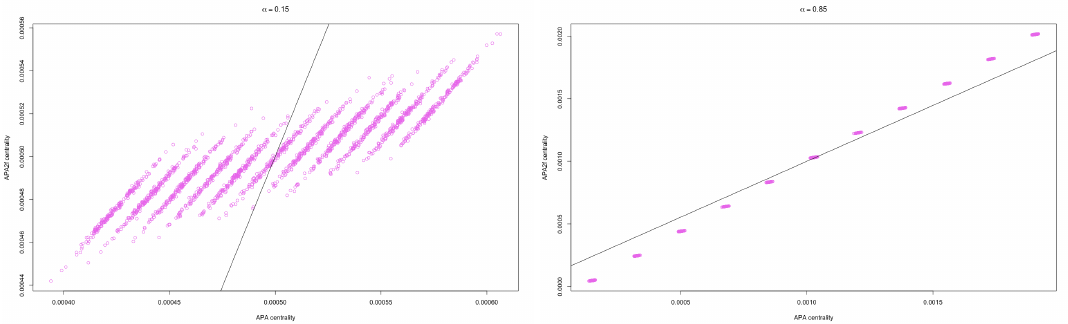
Figure 9. APA and APA2f Spearman’s correlation for a 2000 nodes